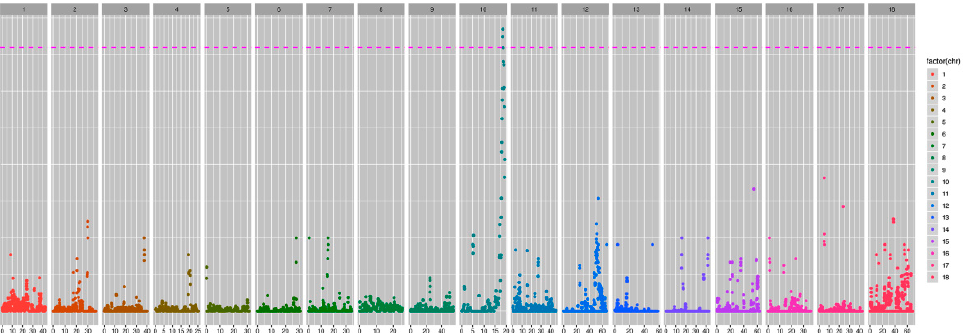
Figure 2. BSA-seq and GradedPool-seq analyses identified the lobed-leaf locus. Note: the abscissa is the chromosome position coordinate, and the ordinate is the ratio of the points whose p value is lower than the threshold value to the total number of points in the window. The higher the position of the point, the closer the correlation with the trait. The threshold of p value is 10 − 10 .